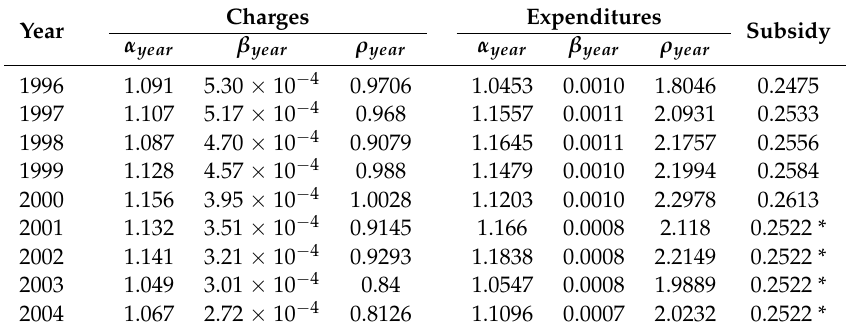
Table 2. Parameter values that vary by year; see text for explanation of subsidy rate for years since 2000.